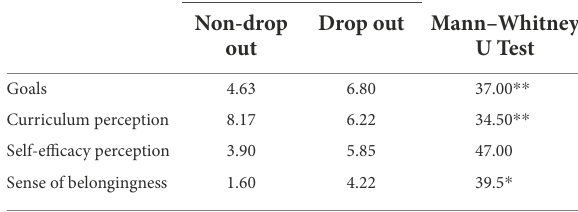
TABLE 2 Mann Whitney U Test on female students (non-drop out vs. drop